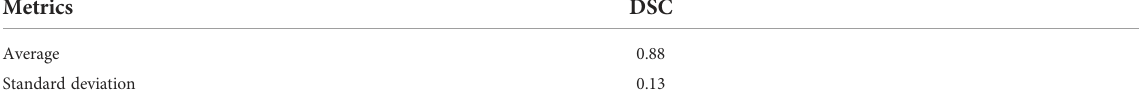
TABLE 2 Details of dice similarity coef fi cient (DSC) and intersection over union (IOU).